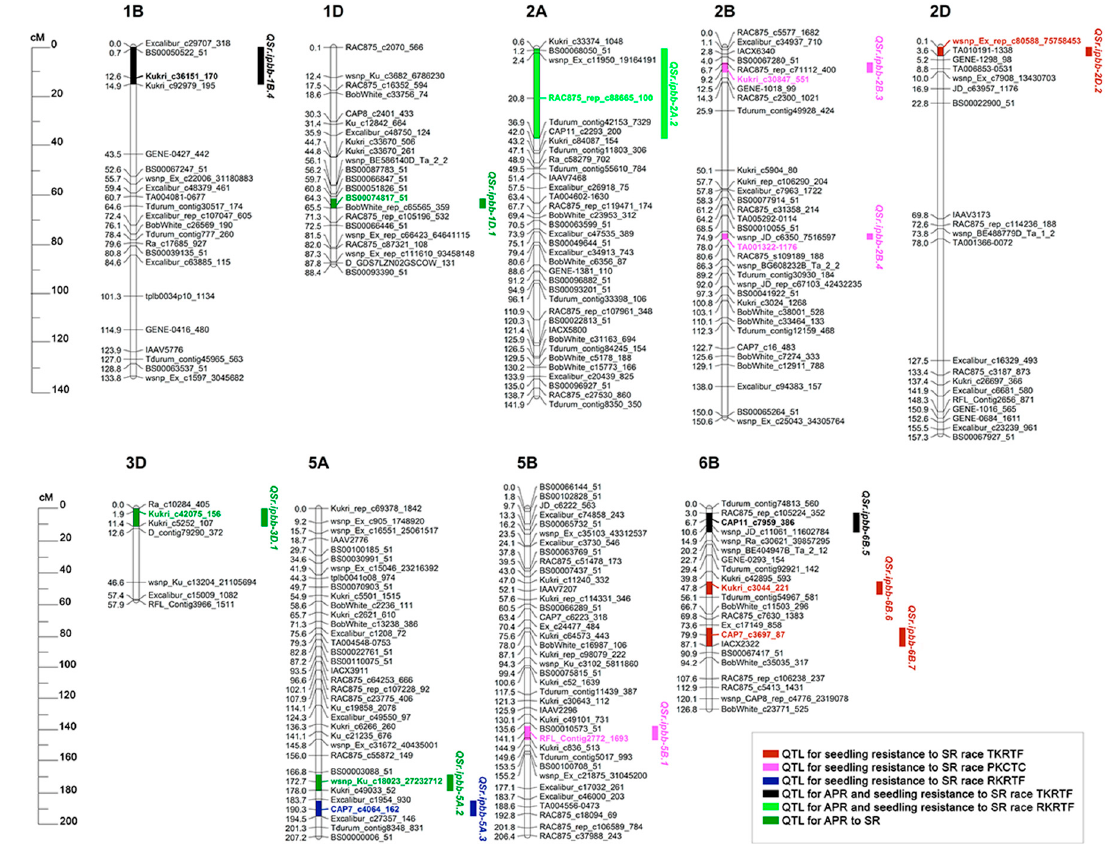
Figure 2. Pamyati Azieva × Paragon genetic map with quantitative trait loci (QTLs) for adult plant resistance (APR) to stem rust (SR) in two regions and seedling resistance to three SR races. The region containing the QTL is indicated by a vertical bar on the right and followed by the name of the QTL. Single nucleotide polymorphism (SNP) markers are positioned on the right and their genetic positions (cM) are shown on the left. The peak marker for each QTL is highlighted in color and bold. Colors of QTL indicate APR or race-specific seedling resistance.